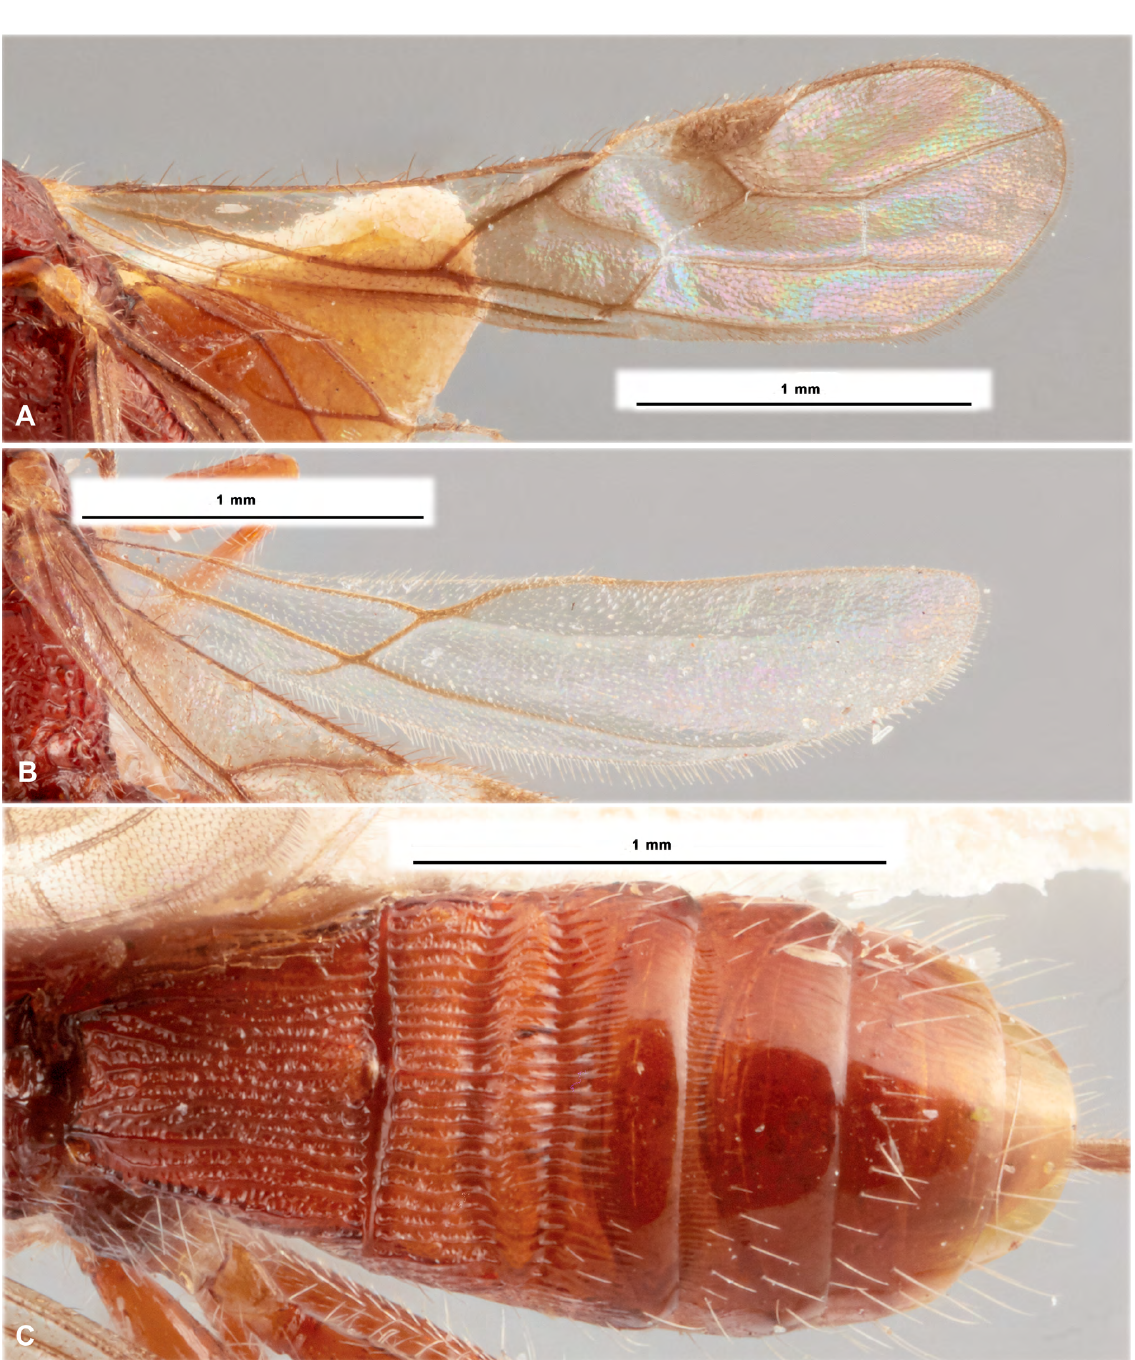
Fig. 27. Neorhaconotus rieki Belokobylskij, Iqbal & Austin, 2004, ♀, holotype, ANIC. A . Fore wing. B . Hind wing. C . Metasoma, dorsal view. Image copyright of Dr. Olivia Evangelista, Australian National Insect Collection